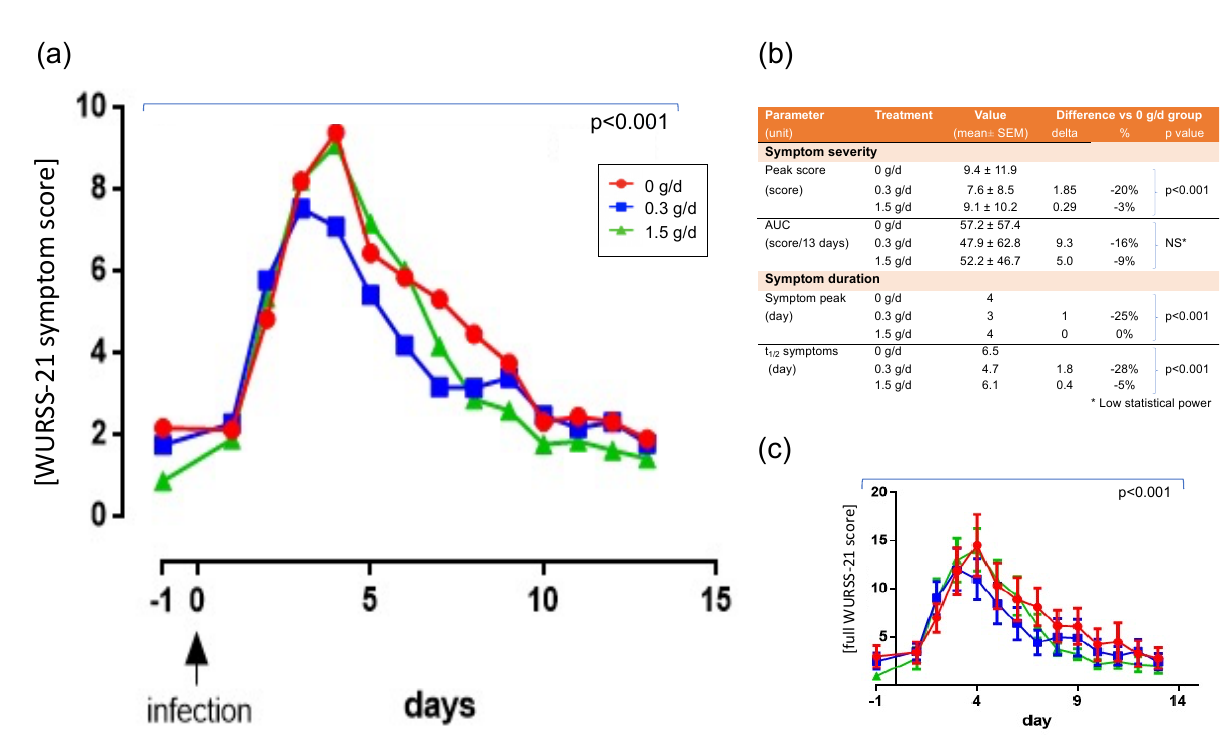
Figure 2. Perceived symptoms following infection with RV16. Symptom score (primary outcome, item 2-11 of WURSS-21 questionnaire, shown without error bars for clarity). The GEE model (fit established via Wald Chi square: 1480.72; p < 0.0001) showed a parabolic association in time as well as dose of cRG-I. Analyses showed a highly significant shift of the curve to the left (reduction in duration) and lower maximum (reduction in severity) over the 13 days following infection. These effects were parabolically associated, with the dose of cRG-I being very apparent in the 0.3 g/day group whereas the 1.5 g/day group was similar to the no-dose group ( a ). Quantification of effects on symptom severity using peak score and AUC, and on duration using symptom peak day and pharmacokinetic modelling of the t1/2 symptoms/day; * low statistical power ( b ). Full WURSS-21 score including the quality-of-life items, shown with SEM to illustrate variability between subjects. The GEE model (fit 2681.77; p < 0.0001) yielded a similar parabolic dose-dependent outcome: p < 0.001, indicating that for the 0.3 g/day group, the full WURSS-21 score and also the peak score was lower and reduced earlier. Post-hoc quantification of effect sizes for the 0.3 and 1.5 g/day groups indicated a reduction in symptom score height of 22% and − 0.1%, and a reduction in peak response/day of 14% and 0.3%, respectively ( c ).